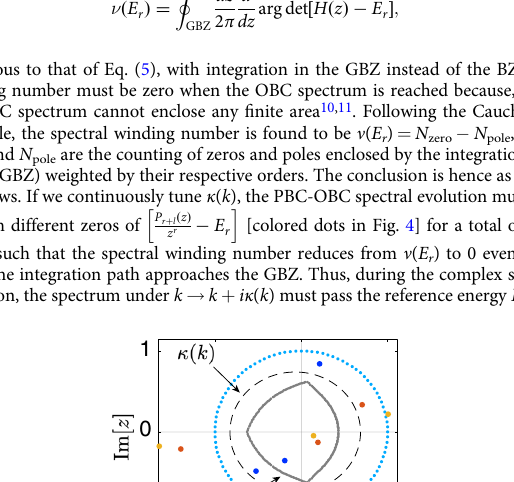
Fig. 4 A typical example of the Brillouin zone (BZ) and the generalized Brillouin zone (GBZ). The BZ and GBZ are given by cyan and gray dots, respectively, in the complex plane of z ≔ e ik e − κ ( k ) . Here κ ( k ) represents a complex deformation of the momentum k . The black dash loop indicates an evolving GBZ with κ ( k ) between 0 and κ OBC ( k ), the value that gives the spectrum under the open boundary condition. Blue, red, and yellow dots are the zeros of H ( z ) − E r , where H ( z ) is the PBC Hamiltonian of the system and E r is the chosen reference energy for calculating the winding number. The system is chosen as the same as that in Fig. 1 in the main text, i.e., H ( z ) = 2 z 2 + z + 1/2 z